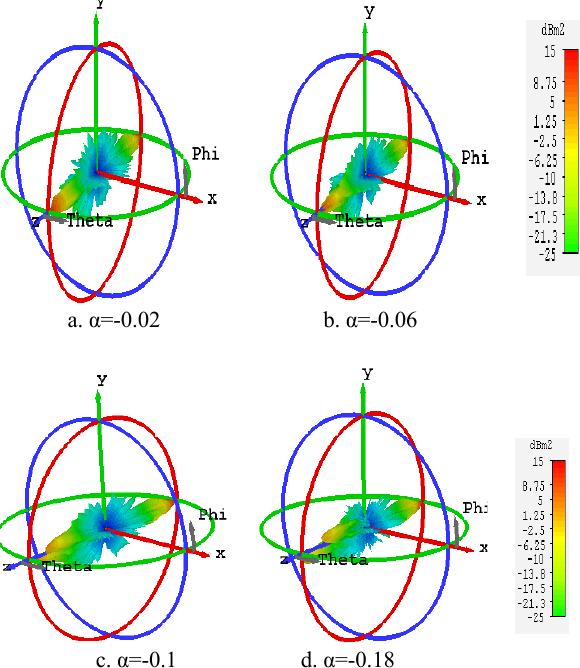
Fig. 15. The 3-D RCS for two dimension holes tapering off- diagonal for α=-0.18, R o = 1.5 mm, and ζ =1 at 11.75 GHz in different